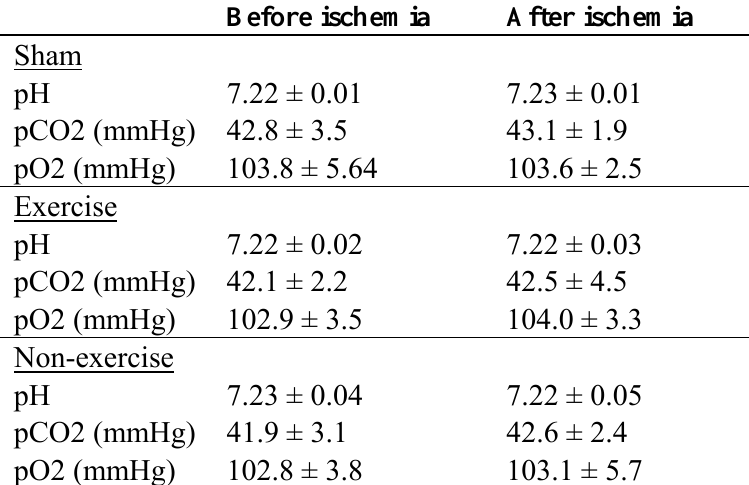
Table 1. Physiological variables among different groups before and after